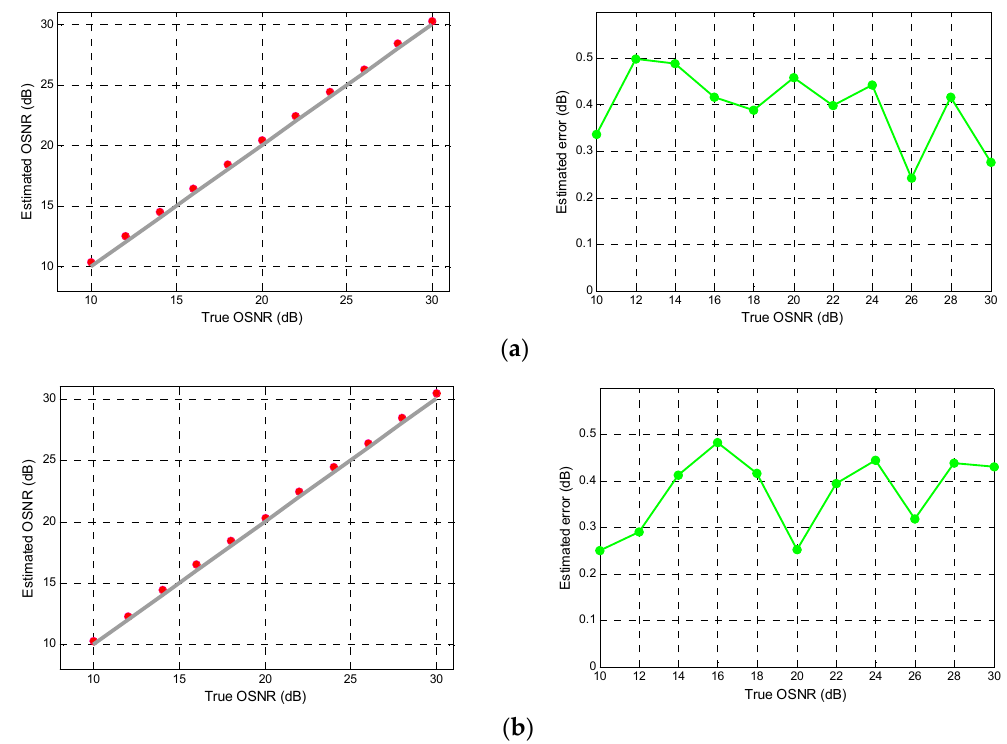
Figure 10. True versus estimated OSNRs and errors for PM-RZ-QPSK signal with ( a ) 100 bin numbers and ( b ) 55 bin numbers using PSO-DNN in different OSNRs.